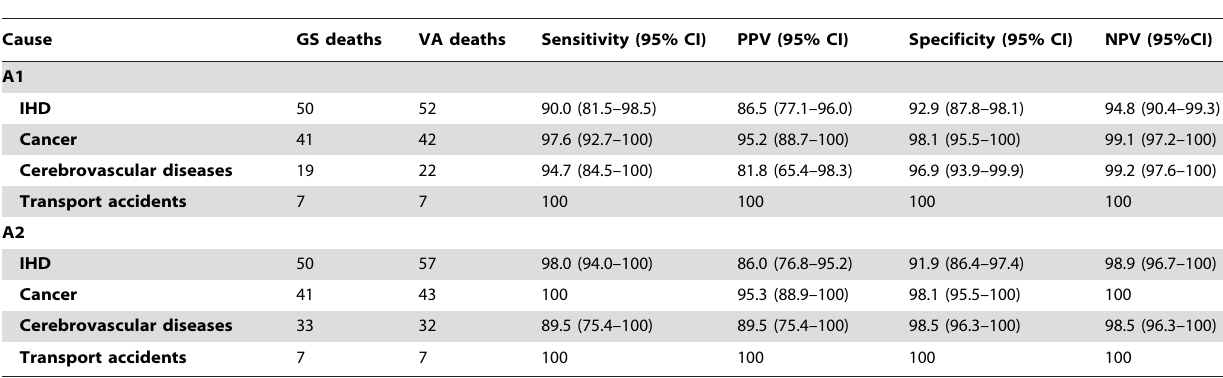
Table 3. Validation results for VA reviews in diagnosing cause of death for 4 selected causes in 149 documented